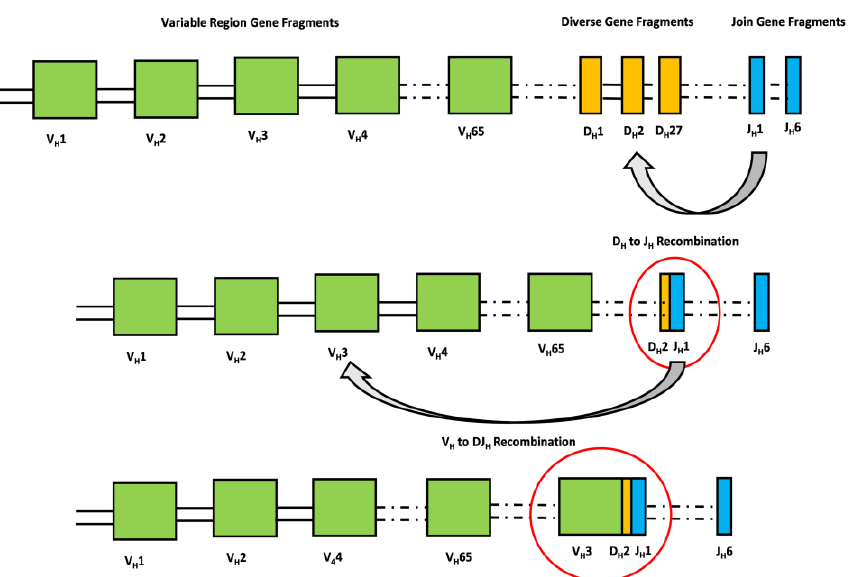
Figure 1. The antigen-binding domain of immunoglobulins is composed of two polypeptide chains, namely heavy and light chains. The exons that encode the antigen-binding domains of the heavy chain are assembled from V (variable), D (diversity), and J (joining) gene segments by a process defined as “cut-and-paste” DNA rearrangements. This process, named V(D)J recombination, selects a pair of segments, introduces double-strand breaks next to each segment, deletes the intermediate DNA, and ligates the segments together. Rearrangements take place in a well-ordered way, with D-to-J joining proceeding before a V segment is joined to the rearranged D–J segments. The rearrangement of the light chain is identical except for the absence of D gene fragments.